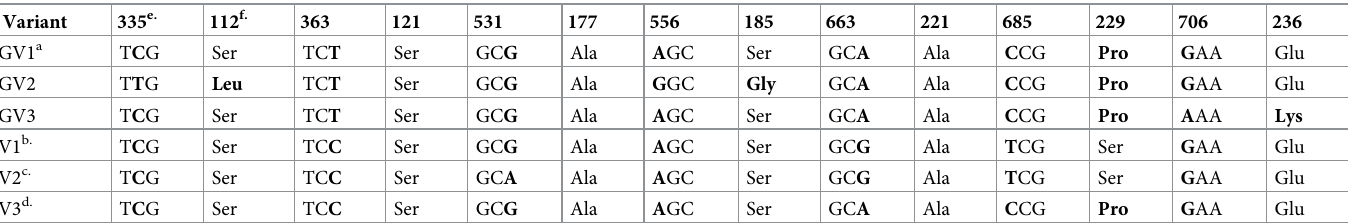
a. GV1, GV2, GV3 represent the three variants from Ghanaian strains of A . marginale . b. V1 represents St. Maries, Virginia, Kansas 6DE, Colville C51 and C52, and Nayarit (MX) N3574. c. V2 represents Puerto Rico, Dawn (AU), Nayarit (MX) N4506. d. V3 represents Kansas EM F .